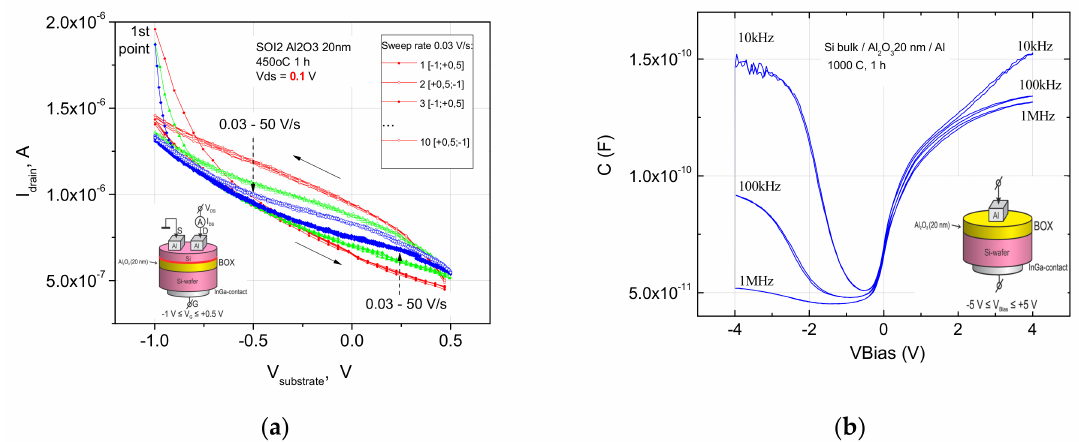
Figure 2. ( a ) Hysteresis-like behavior of the drain-gate characteristics at the range V g = − 1.0 + 0.5 V of n-SIS pseudo- MOSFET (metal-oxide-semiconductor field effect transistor) with the 500 nm n-Si/20 nm Al 2 O 3 /n-Si substrate after the furnace annealing (FA) at 450 ◦ C during 1 h. Potential V g was applied to the n-Si substrate. The drain voltage V DS was 0.1 V for all pseudo-MOSFET measurements. The sweep rate was 50 V/s, 5.0 × 10 − 1 V/s, 3.3 × 10 − 3 V/s (shown by dashed arrows). In the inset are the measurement scheme and the layers of the n-SIS structure, where the bonding interface is indicated by a red line; ( b ) C-V plots of the MIS structure with high-k insulator Al 2 O 3 after the final FA at 1000 ◦ C for 1 h and top Si layer etching. In the inset are the measurement scheme and the n-type MIS structure